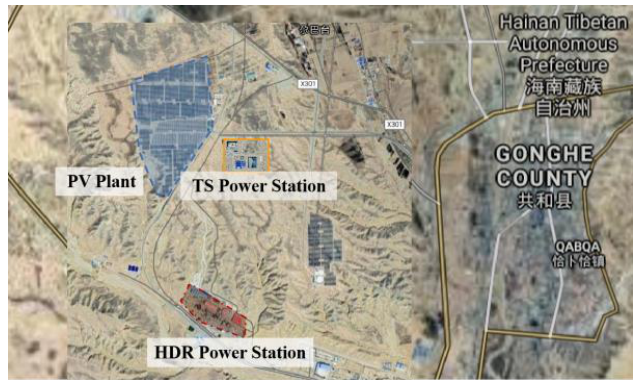
Figure 3. Scenario diagram of the hybrid power system.